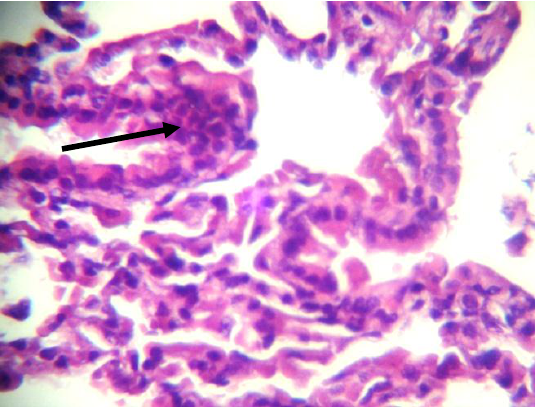
Fig 8: Microscopic section of liver from 1st immunized group at 3 days post challenge show slight dilation of sinusoids with few MNCS infiltration around blood vessels & bile ducts mm (H&E X20).